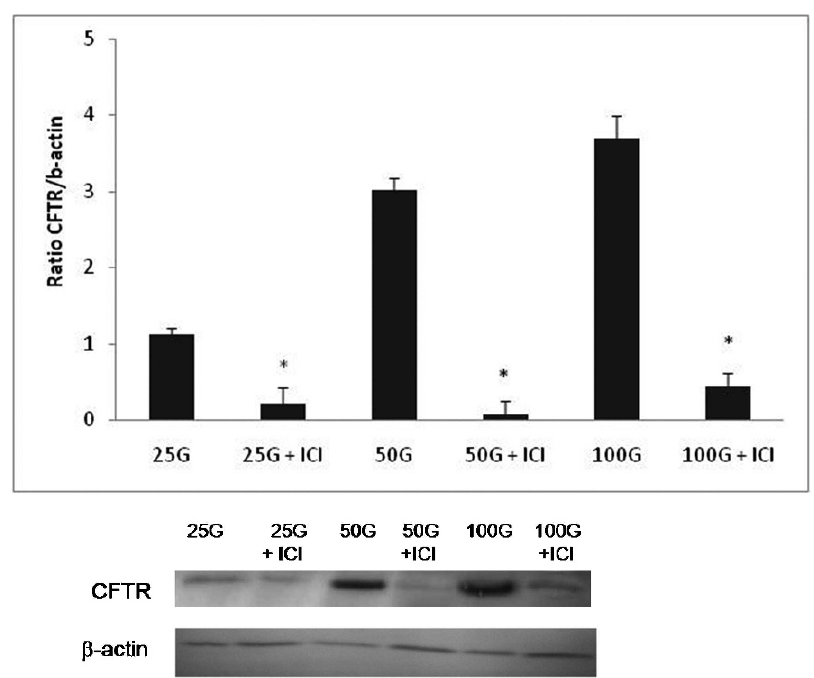
Figure 4 - The level of CFTR protein expression in ovariectomised rats treated with different doses of genistein (25, 50, and 100 mg/kg/ day) with and without ICI 182780. The expression of CFTR protein was increased in a dose-dependent manner with increasing doses of genistein, and this increase was significantly antagonised by ICI 182780. * p , 0.05 compared with the respective treatment group without the presence of ICI 182780; n=6 per group. The data are presented as the mean ¡ SEM. 25G=25 mg/kg/day genistein, 25G